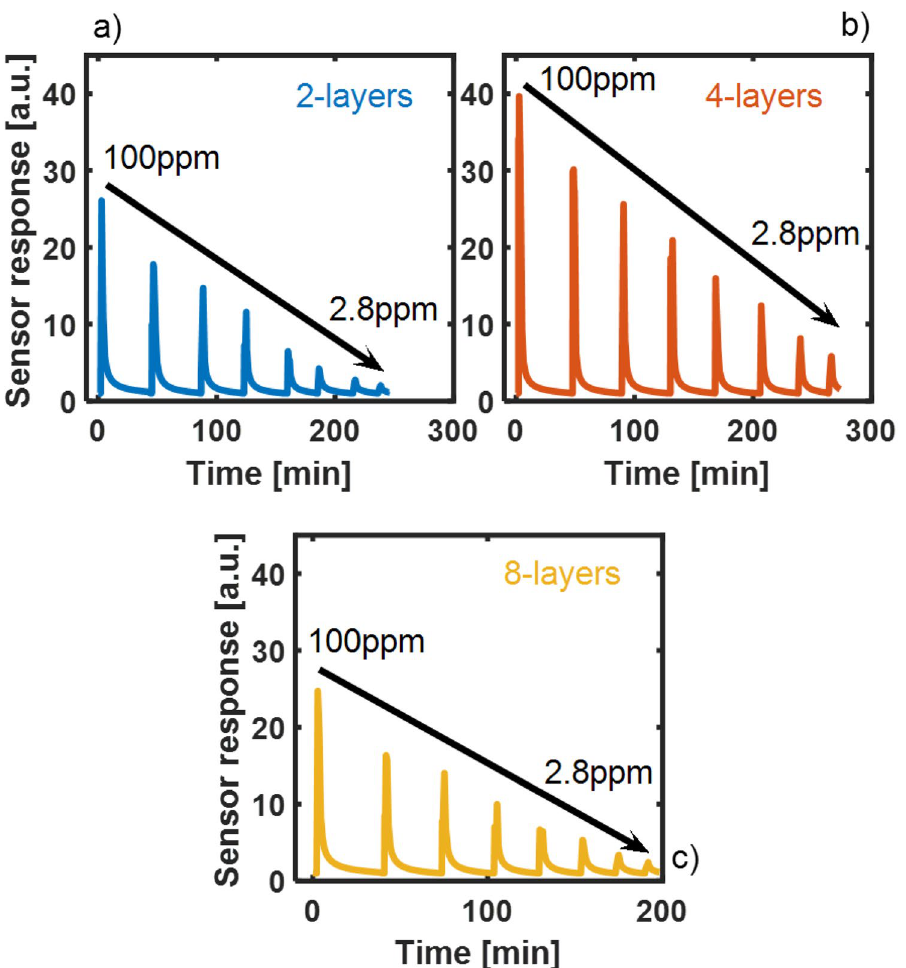
Figure 5. Response curves toward different concentrations of NO 2 at room temperature for the fabricated ( a ) 2-layers, ( b ) 4-layers and ( c ) 8-layers